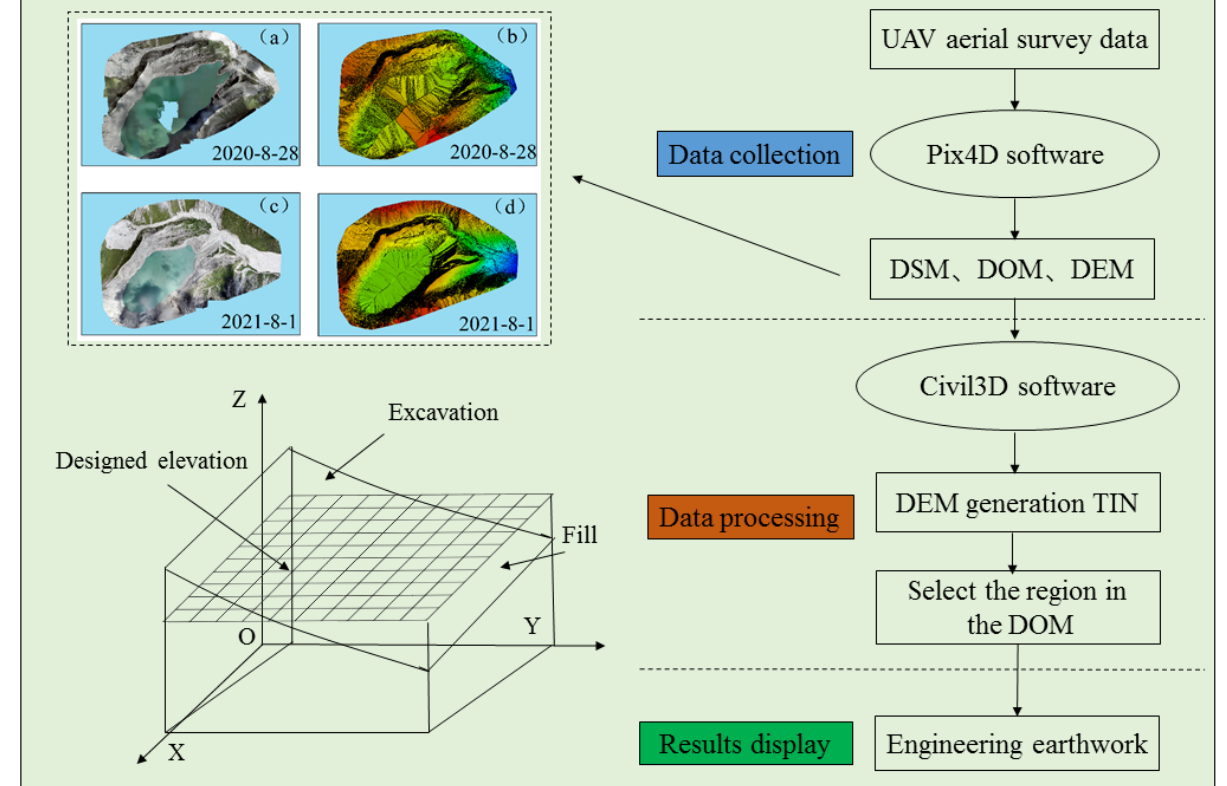
Figure 4. Flow chart for earth and rock volume calculation. ( a ) DOM - 28 August 2020. ( b ) DSM -